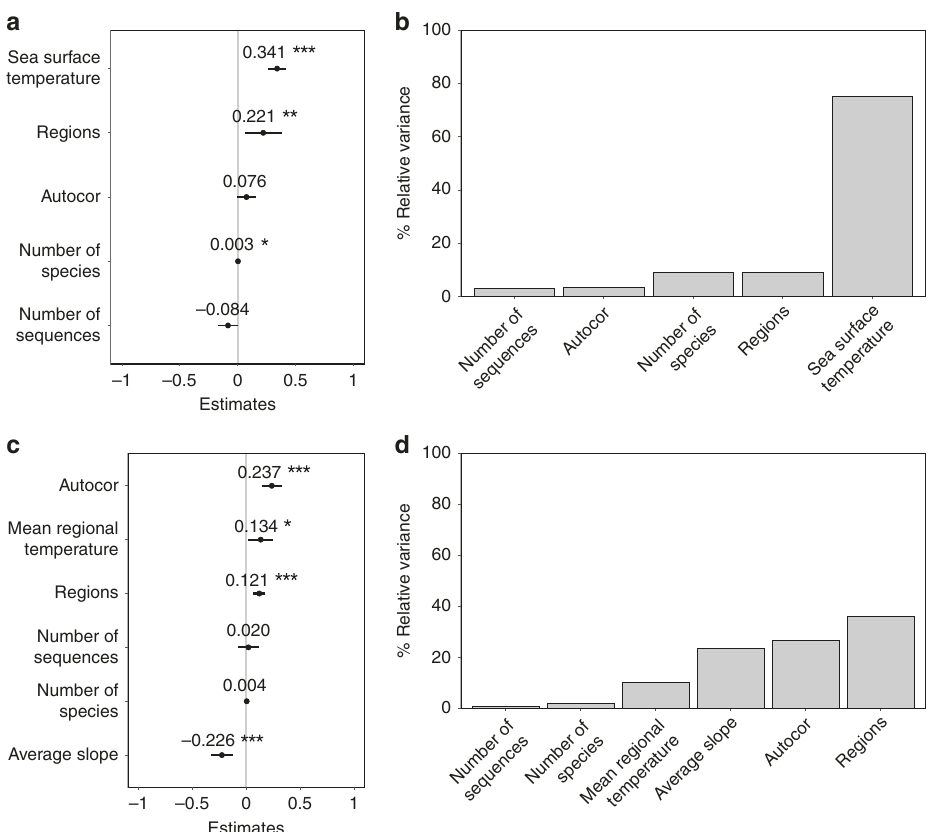
Fig. 3 Determinants of fi sh genetic diversity patterns. Outputs of the linear models (lm) testing the effect of geographic, environmental and sampling factors on the global pattern of marine ( a , b ) and freshwater ( c , d ) genetic diversity (See Supplementary Table 3 and 5 for details on models). Coef fi cients and con fi dence intervals for the factors of the models for marine ( a ) and freshwater fi shes ( c ). Con fi dence intervals were estimated from the standard error of each coef fi cient at a level of 5% and were obtained with the command con fi nt in the R package lm . Autocor is a spatial autocovariate that takes into account spatial autocorrelation in both our predicted and predictive variables. Relative variance of genetic diversity explained by the various factors was estimated and represented as partial plots with the package hier.part in marine ( b ) and in freshwater fi shes ( e